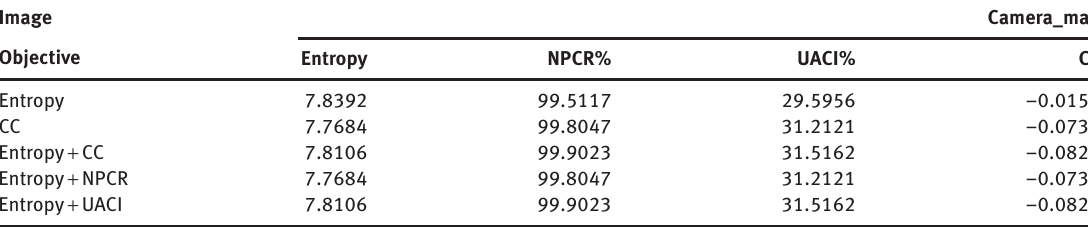
Table 2: Comparative Analysis for Camera_man Image Using Logistic Map